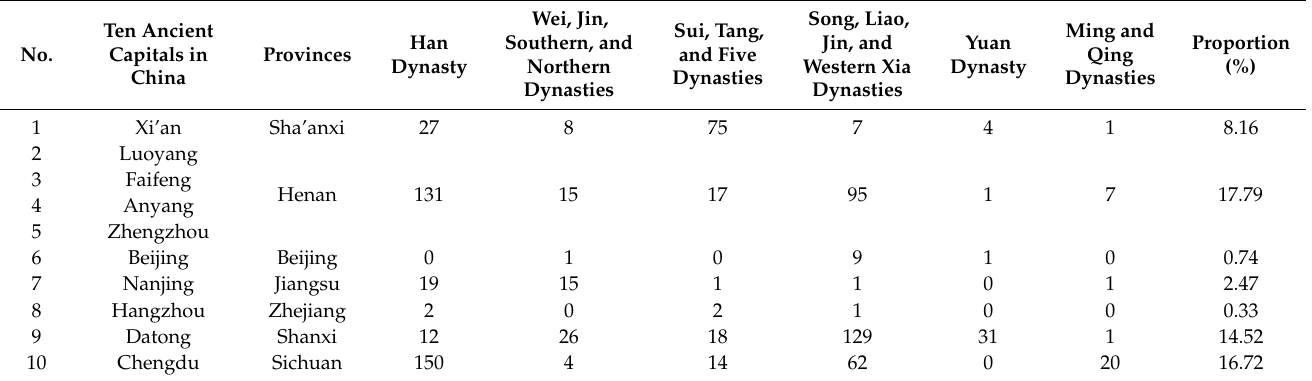
Table 2. Statistics related to tomb mural relic sites in the provinces where ten ancient capitals are